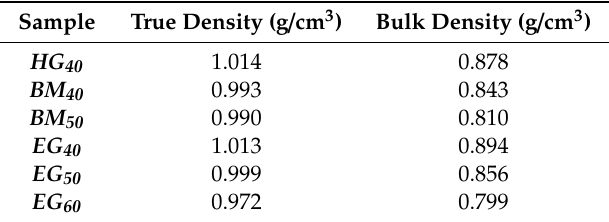
Table 2. True density and apparent bulk density of the stable